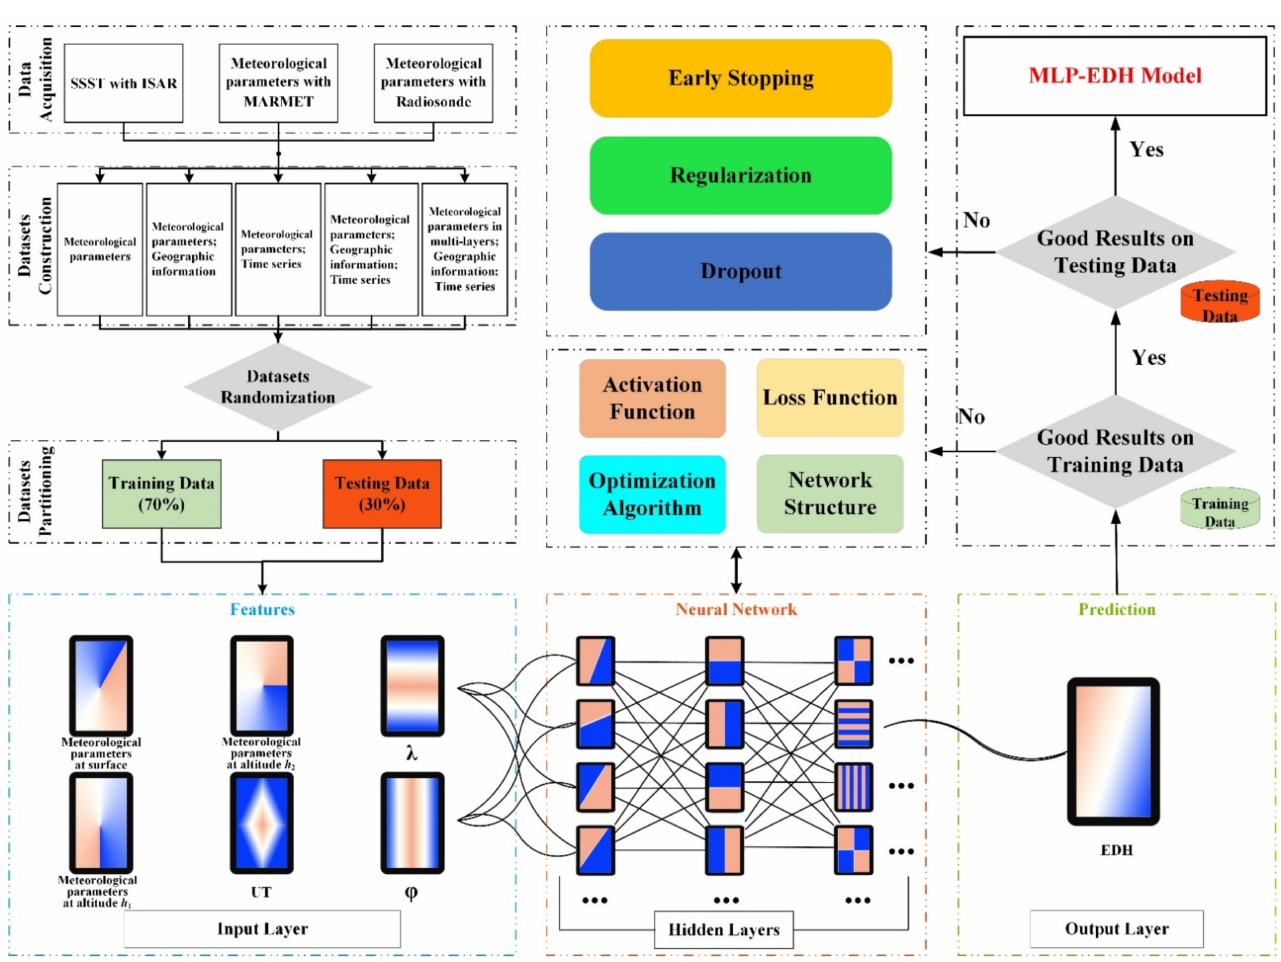
Figure 5. The modeling